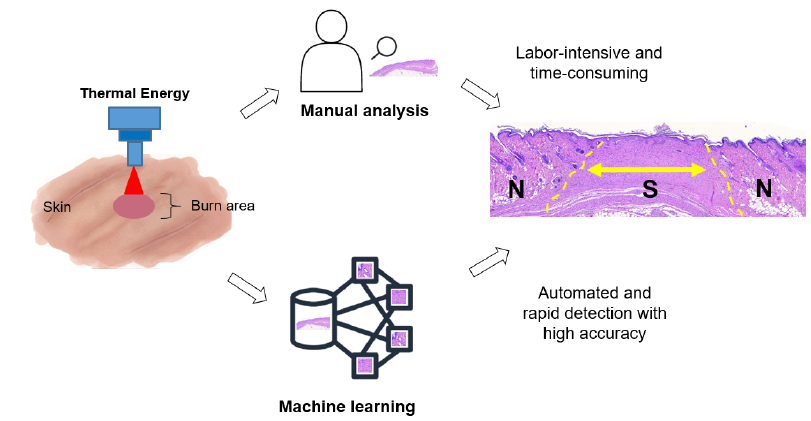
Figure 1. Schematic comparison between manual detection and machine learning for histology analysis of scar tissue (ML = Machine learning; N = Normal; S =